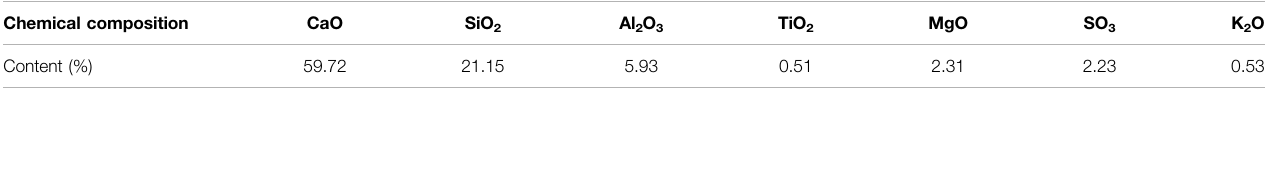
TABLE 1 | Chemical composition of Portland cement (PO42.5).